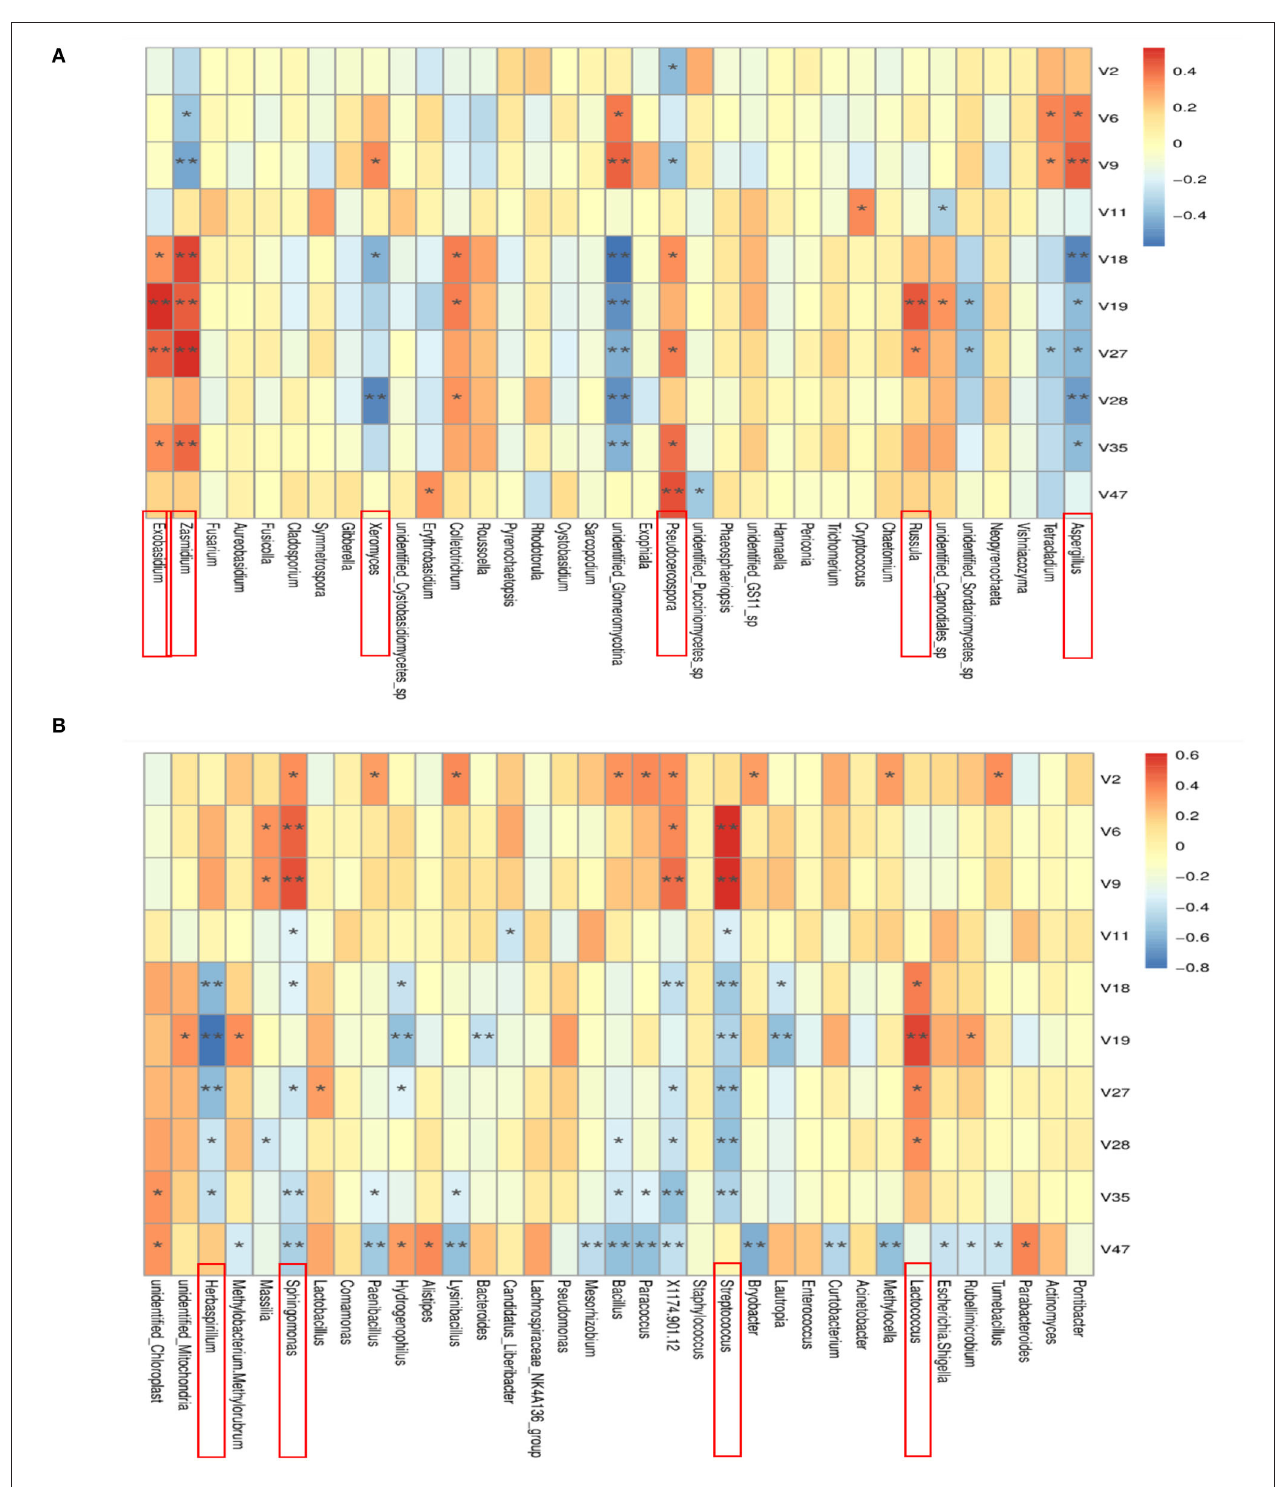
FIGURE 11 | Spearman correlation analysis heat map between the top 35 bacteria (A) and fungi (B) in relative abundance and the chemical markers that change significantly during aging of Citrus reticulata “Chachi”. The closer r is to 1 (red), it indicates a positive correlation, and the closer to − 1 is a negative correlation (blue). The asterisk represented the level of significance, “*” represented p < 0.05, “**” represented p < 0.01.